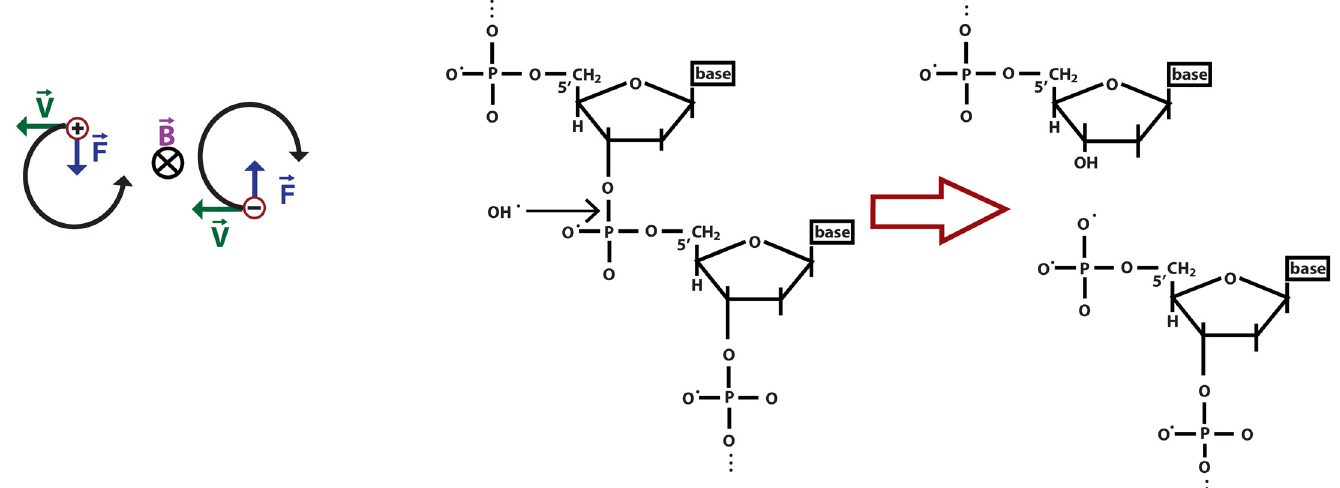
Fig 4. Lorentz force and DNA. (a) Diagram shows the Lorentz force F defined in terms of acting on a charge q that moves in a magnetic field with a velocity v. The F direction is the opposite for a positive charge versus a negative charge. Fig 4(b) meanwhile illustrates the interaction of DNA and the nucleophile